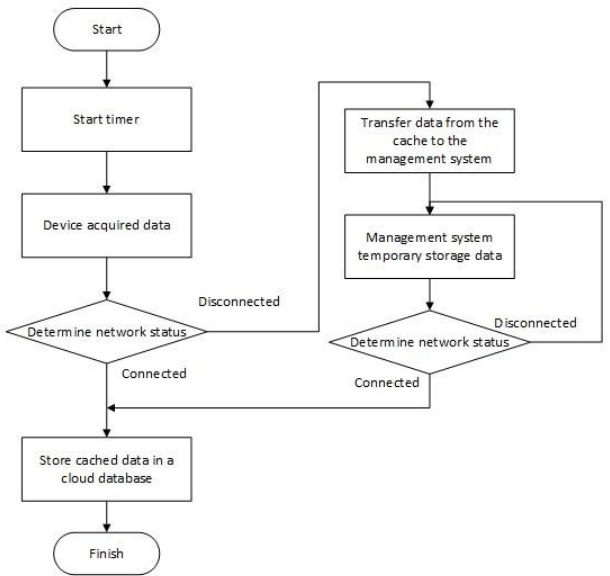
Figure 7. Local transmission strategy of the routing node flow chart.